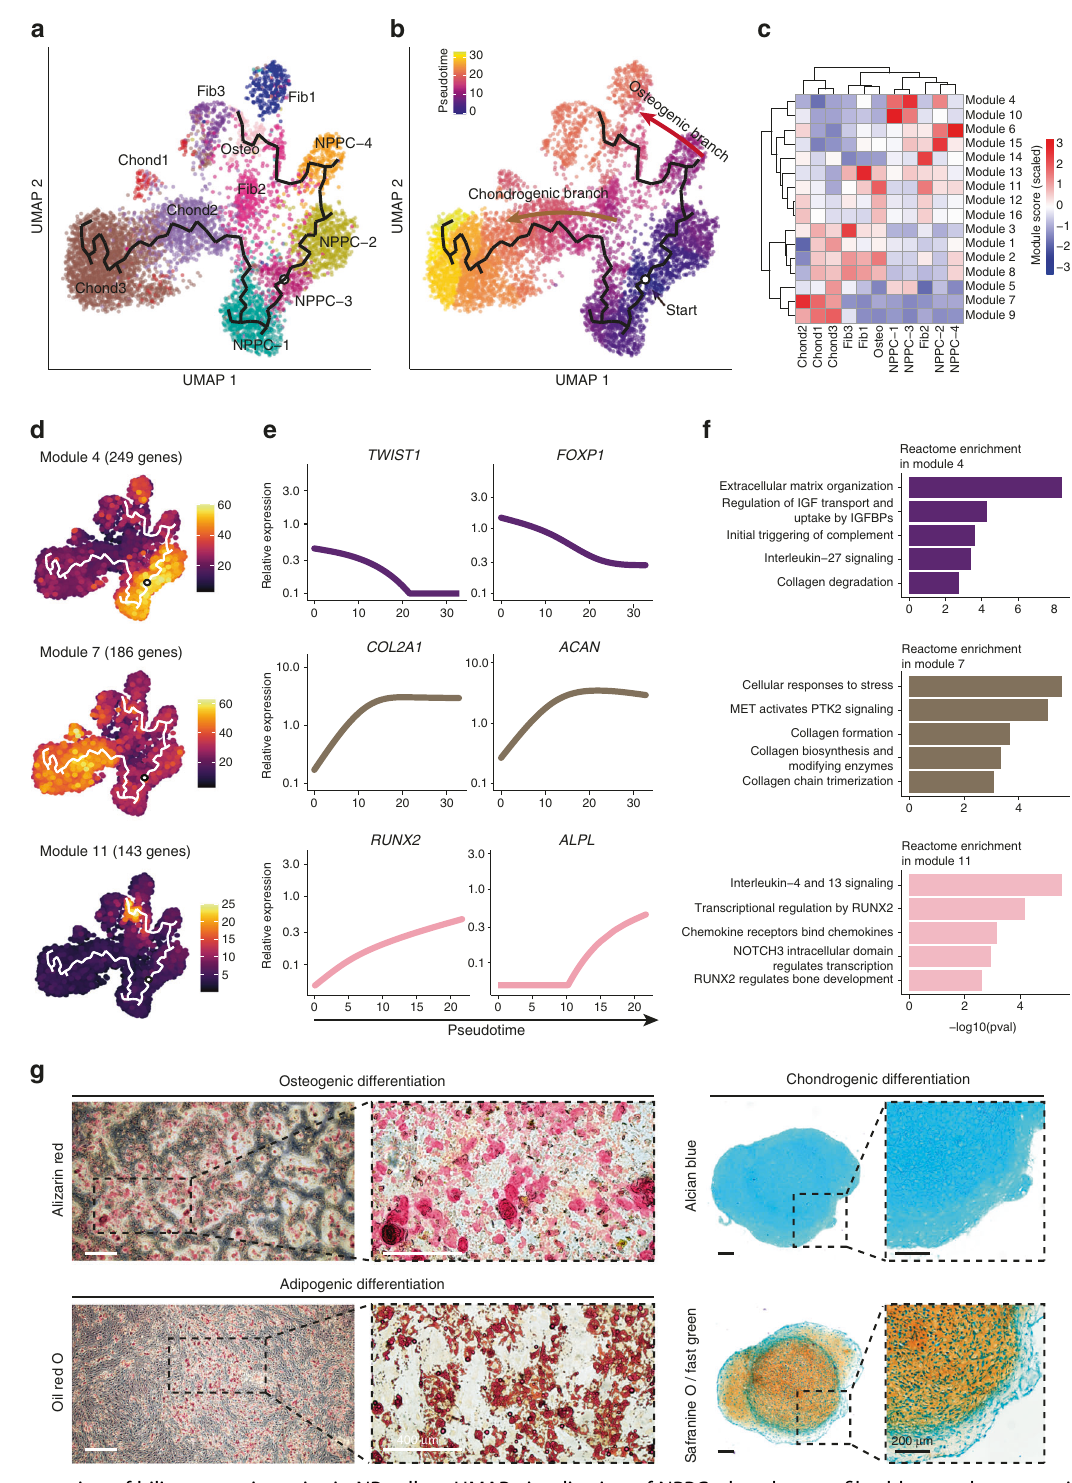
Fig. 4 Reconstruction of bilineage trajectories in NP cells. a UMAP visualization of NPPC, chondrocyte, fi broblast, and osteogenic subclusters. The principal graph of trajectories reported by Monocle 3 was rooted in NPPC-3, as indicated by a cycle. UMAP, Uniform manifold approximation and projection. b Developmental pseudotime for cells present along the trajectory inferred by Monocle 3, with osteogenic and chondrogenic branches coming from NPPC subclusters. c Heatmap showing the scaled mean expression of modules of coregulated genes grouped by Louvain community analysis across the subclusters. d UMAP plots showing the relative expression level of representative gene modules in NP cell subclusters. e Pseudotime kinetics of the indicated genes in the modules in d from the root along the trajectories to chondrogenic and osteogenic differentiation. f Histogram showing the pathways enriched by ReactomePA for each module indicated in d . g Representative alizarin red (top left), oil red O (bottom left), alcian blue (top right), and safranine O/fast green (bottom right) staining after the osteogenic, adipogenic, and chondrogenic differentiation of PROCR + cells ( n = 3). Magni fi ed images of the boxed areas are shown on the right. White scale bars, 400 μ m. Black scale bars, 200 μ